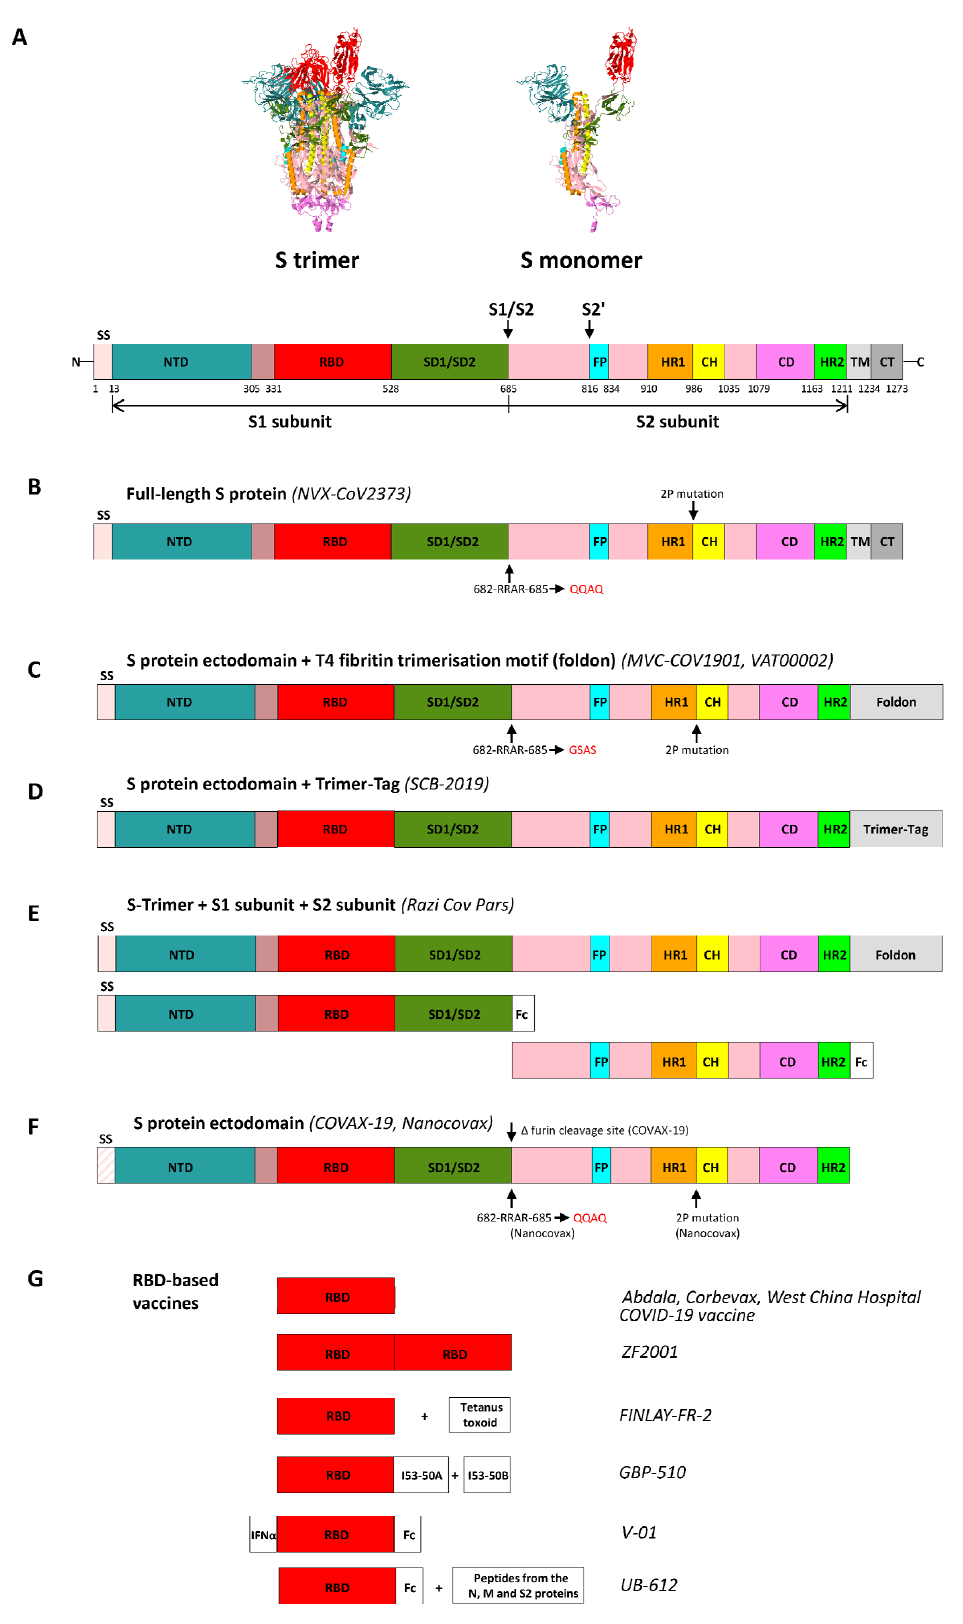
Figure 1. SARS-CoV-2 S protein structure ( A ) and graphical overview of design strategies of recom- binant S protein-based COVID-19 vaccines, being at the phase 3 of clinical trials or approved ( B – G ). ( A ) SARS-CoV-2 S protein monomer and trimer (open state with one RBD in the “up”